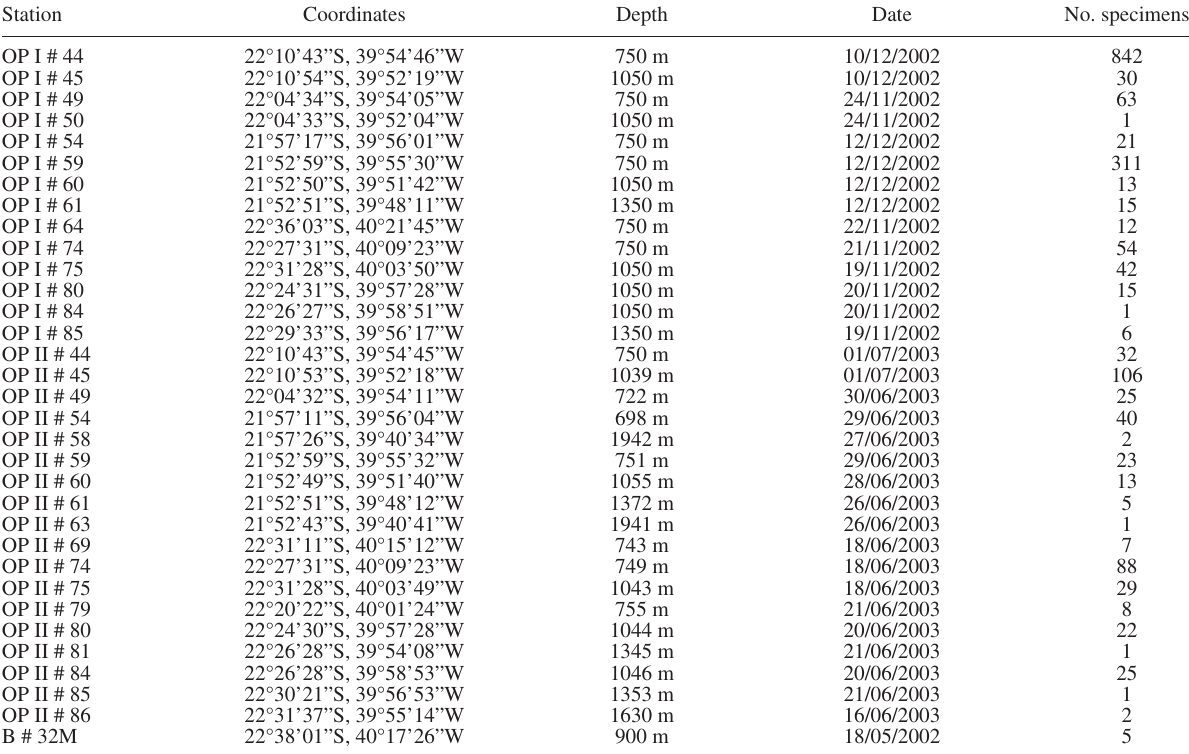
Table 1. – Geographical data for stations sampled with a box-corer. Nº specimens refers to those belonging to the studied subfamilies. Station